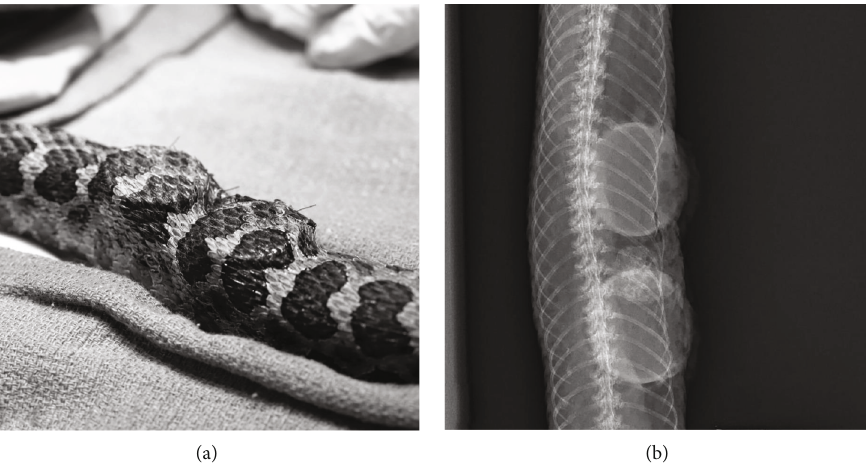
Figure 2: Immediate postoperative (a) photograph and (b) dorsoventral radiograph of a Massasauga rattlesnake ( Sistrurus catenatus ) with two self-in fl ating hygroscopic tissue expanders implanted subcutaneously under the lateral scales.